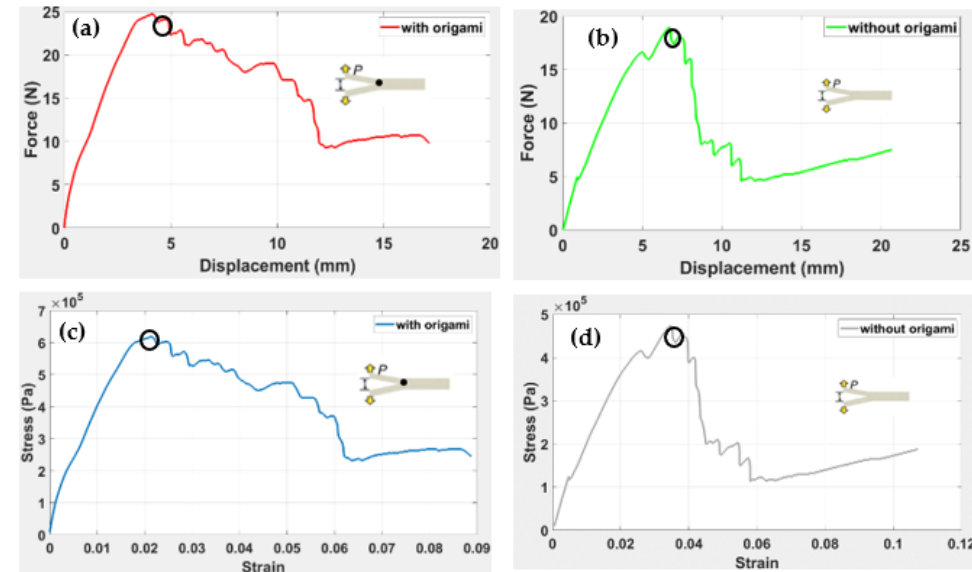
Figure 21. Crack length in DCB under the quasi-static conditions. The load – displacement graphs obtained for the beams with origami capsules and without origami capsules are shown in ( a ) – ( d )